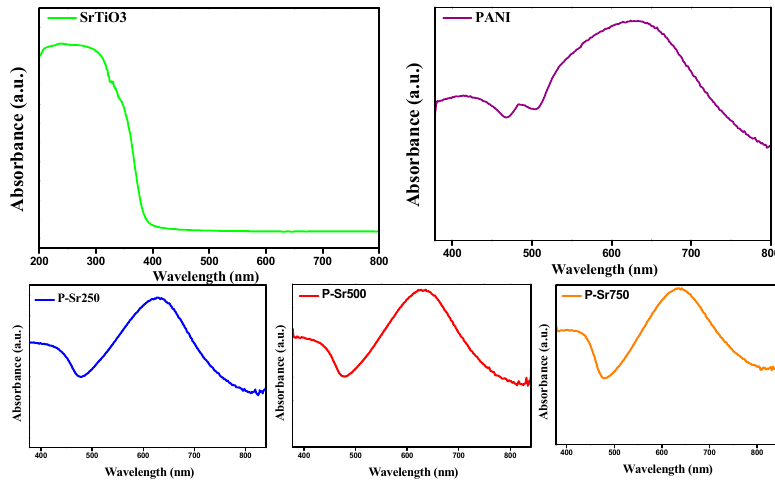
Figure 7. UV–Visible spectra of SrTiO 3 , PANI and different nanocomposites.